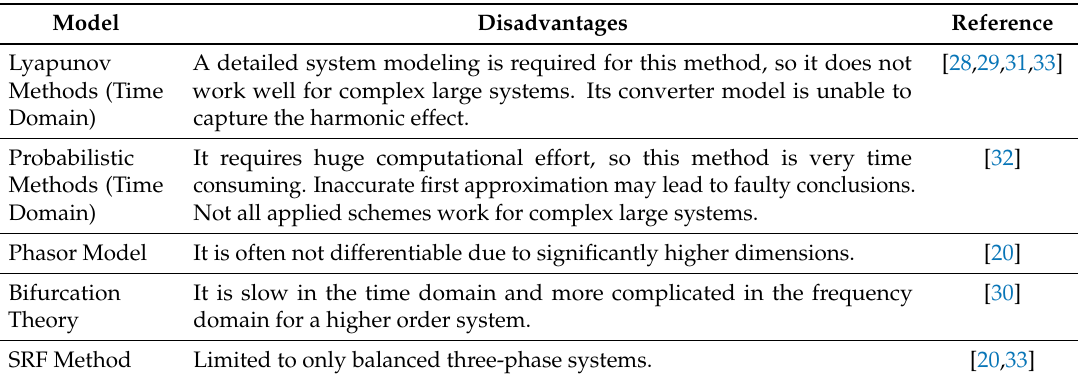
Table 1. Comparative analysis of different stability techniques [20,28–33]. SRF, synchronous reference